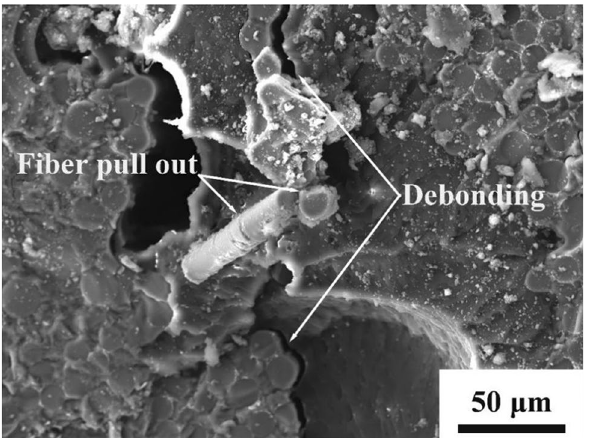
Figure 13. Fractography of SiC f /CaWO 4 /SiC minicomposite oxidized at 1100 °C for 50 h.